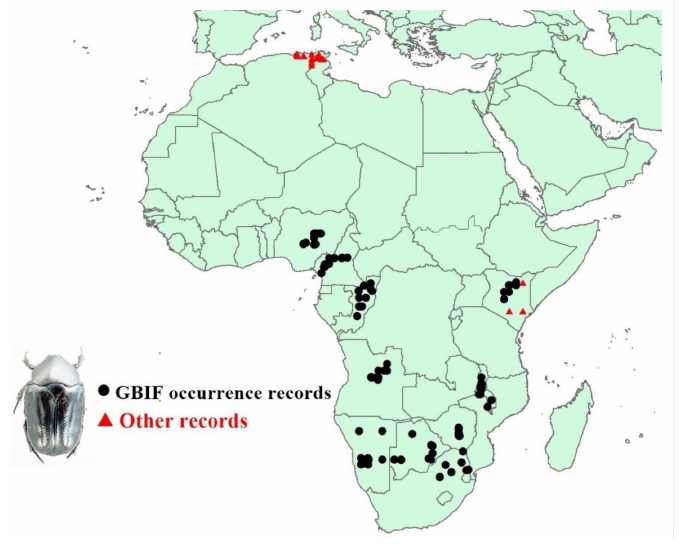
Figure 1. Occurrence record map showing the 118 occurrences, with the differentiation of Global Biological Information Facility (GBIF) data from other